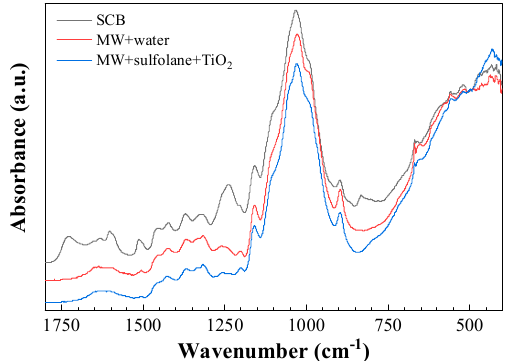
Figure 1. Attenuated total reflection-Fourier-transform infrared (ATR-FTIR) spectra of sugarcane bagasse (SCB) samples: before treatment (black); after microwave irradiation (MWI) treatment with NaOH 3% at 140 °C for 60 min in the water-based medium (red), and in the sulfolane-based medium (blue).